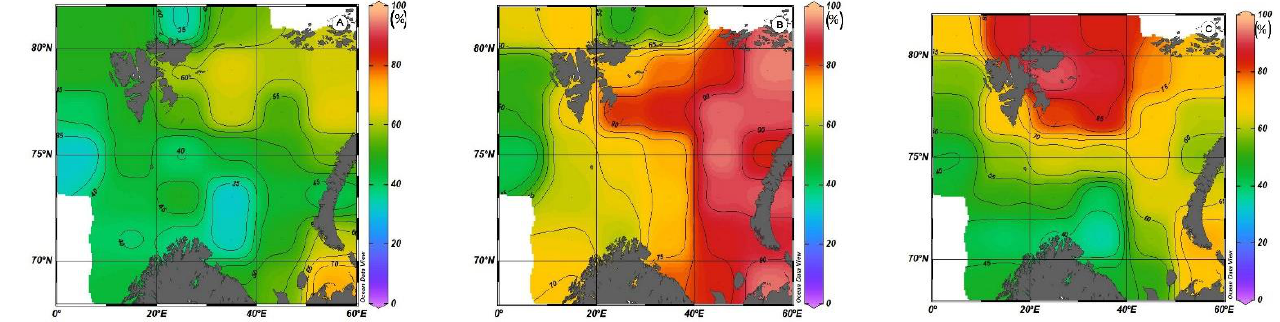
Figure 6. Nutrients (P-PO 4 (%) ( A ) N-NO 3 (%) ( B ) and Si-SiO 3 (%) ( C )) intake average values for the period from 1 July to 30 September ( 𝑄 𝑝ℎ𝑦𝑡𝑜𝑛 /(𝑄 𝑐𝑛 ± Δ𝑄 𝑠𝑒𝑑 ) × 100).